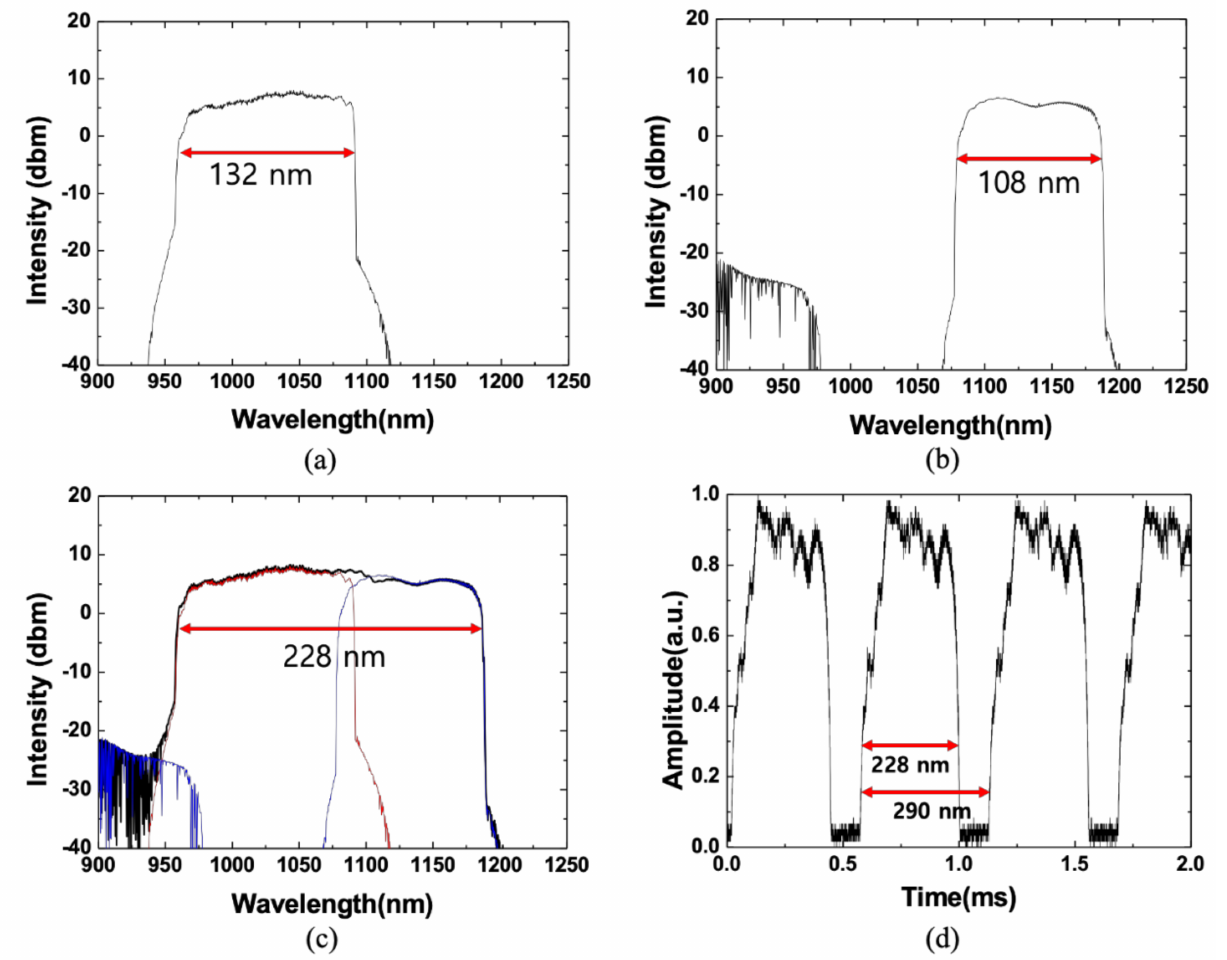
Figure 3. ( a ) Optical spectrum of the WSL when only SOA 1 was connected in the Mach-Zehnder interferometer; ( b ) optical spectrum of the WSL when only SOA 2 was connected in the Mach-Zehnder interferometer; ( c ) optical spectra output and ( d ) corresponding temporal output from the WSL by combining two SOAs in parallel in the Mach-Zehnder